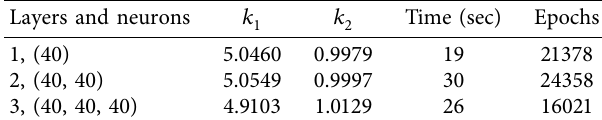
Table 9: Comparison of shallow vs. deep layers for Example 1. Layers and